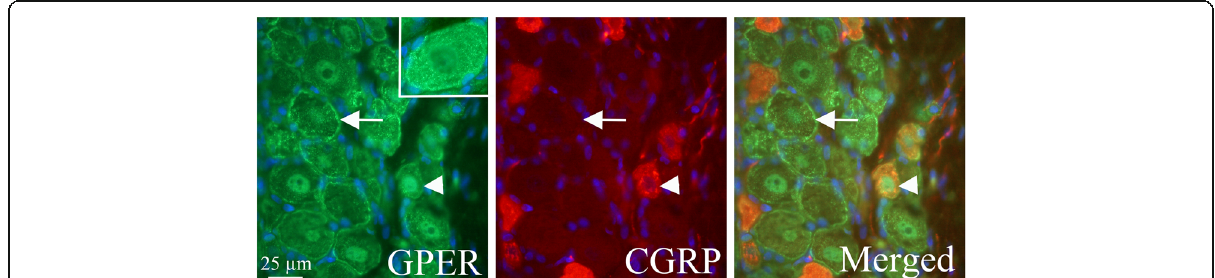
Fig. 8 GPER and CGRP distribution in the TG. Expression of GPER was observed in the cell membrane and cytoplasm in most neurons (arrow and arrowhead). Double immunohistochemistry with GPER and CGRP showed that most CGRP positive cells (arrowhead) also expressed GPER in the cytoplasm. Insert: higher magnification of a GPER positive cell, showing immunoreactivity in the cytoplasm and cell membrane